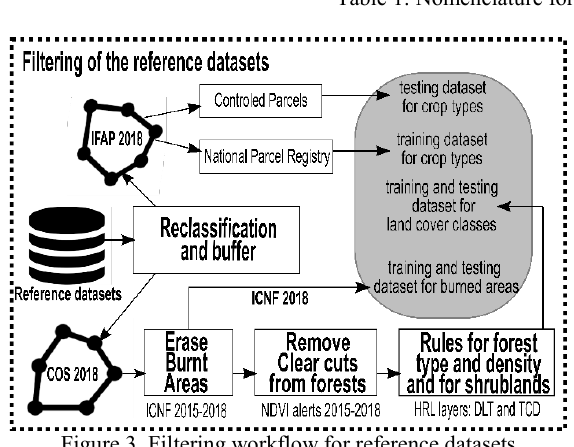
Figure 3. Filtering workflow for reference datasets The buffer strategy was also applied to COS 2018 classes.